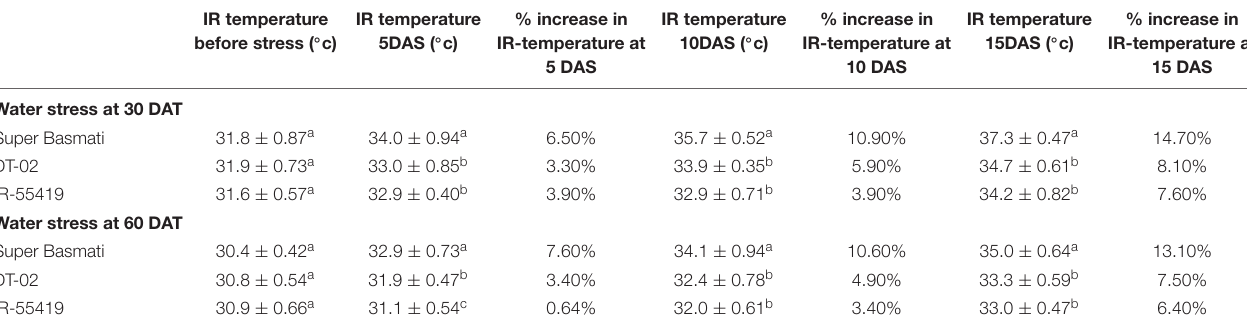
TABLE 3 | Infrared thermal imaging to study the effect of water stress on plant temperature during early and later growth stages under net house conditions. IR temperature IR temperature % increase in IR temperature before stress ( ◦ c) 5DAS ( ◦ c) IR-temperature at 10DAS ( ◦ 5 DAS